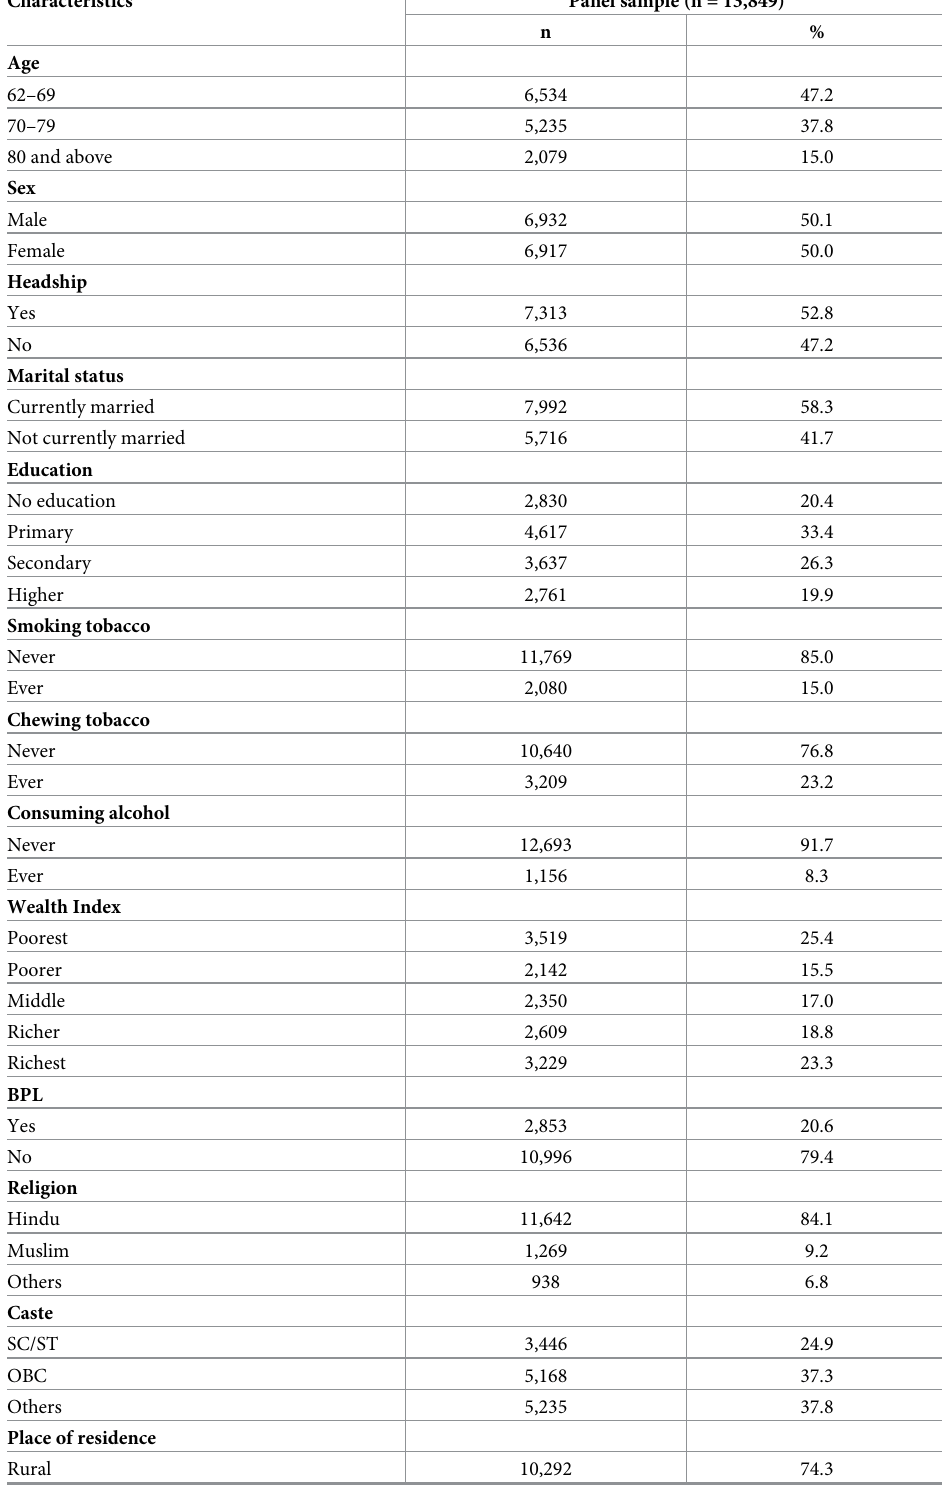
Table 1. Distribution of older adults by their socio-economic and demographic